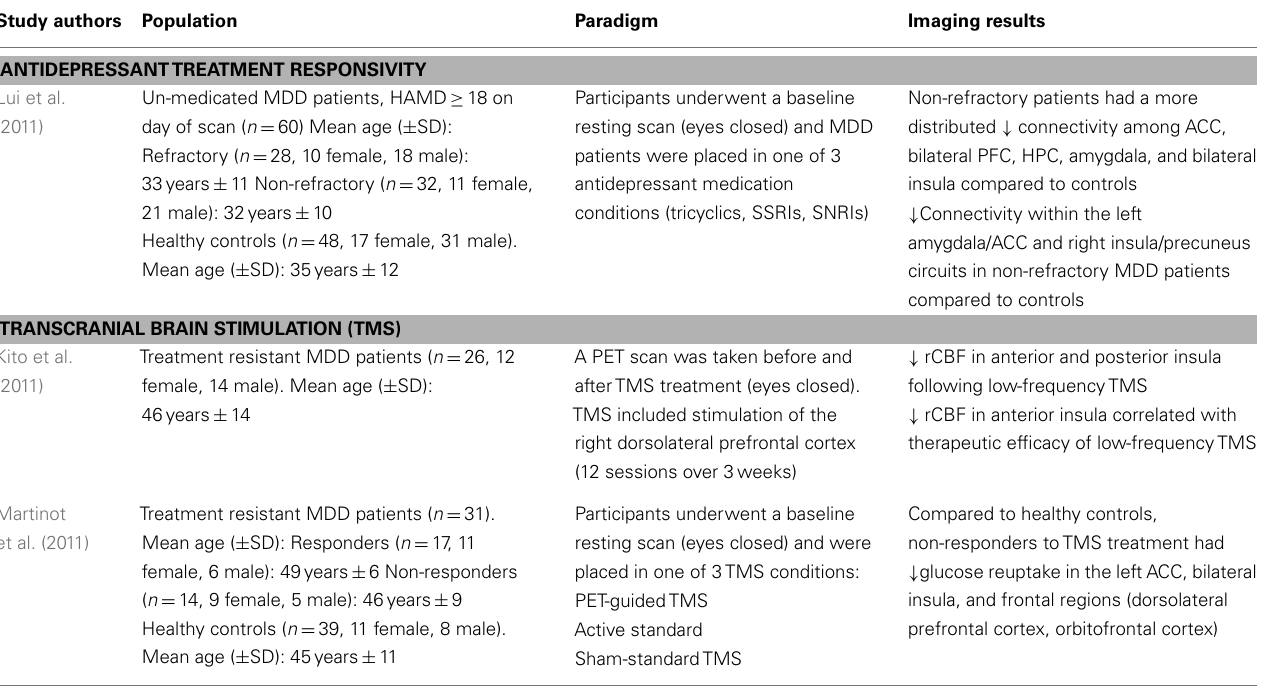
Table 2 | Imaging studies using a treatment-based study paradigm in patients with